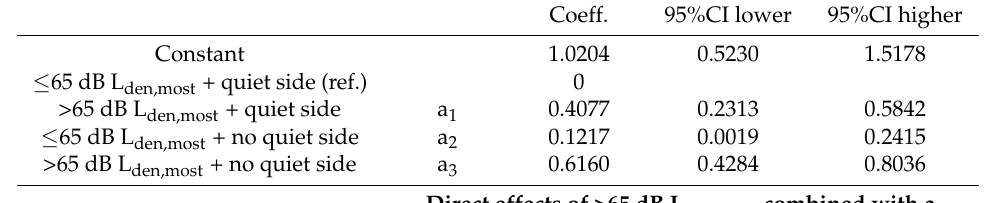
Table 10. Joint associations of exposure to road traffic noise (>65 dB L den,most ) and present/absent quiet side (>40 dB L den,least ) with perceived noise control and noise annoyance 1 . Total Effects of >65 dB L den,most Combined with a N = 1812 Present/Absent Quiet Side on Noise Annoyance Coeff. 95%CI lower 95%CI higher Constant 0.7428 0.3900 1.0956 0.2948